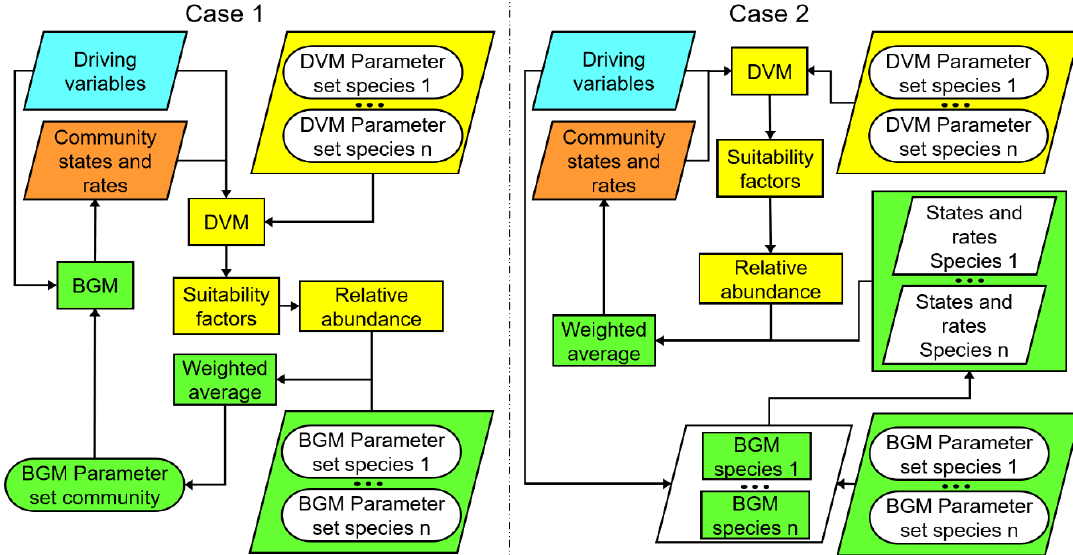
Figure 6. Two ways to implement the CoSMo approach. Case 1: parameter averaging. Case 2: process rate averaging. Background colors indicate different parts of the modelling framework. Cyan: external drivers. Yellow: dynamic vegetation modelling. Green: biogeochemistry modelling. Orange: state equations.